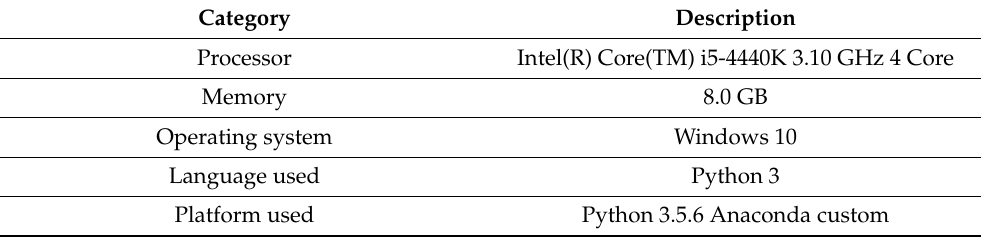
Table 4. Evaluation environments.